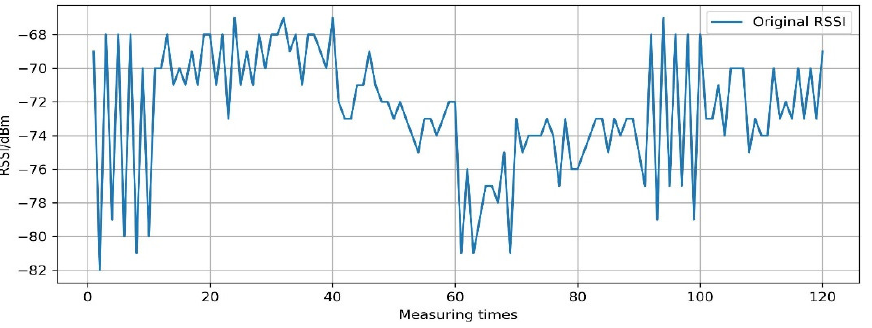
Figure 8. The original RSSI value of () .